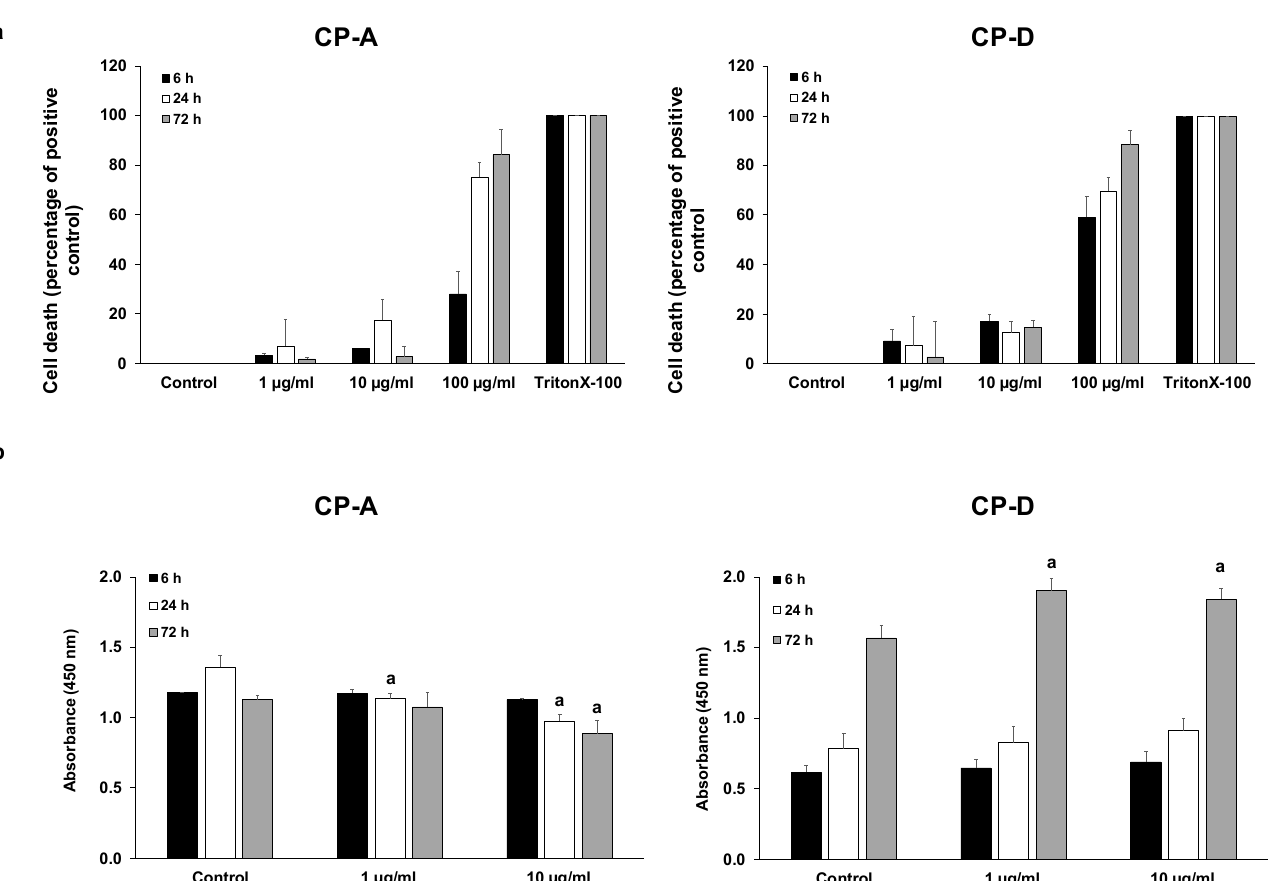
Figure 1. Effects of cigarette smoke extract (CSE) treatment on cell viability and proliferation. Metaplastic (CP-A) and dysplastic (CP-D) esophageal cell lines were exposed to different concentrations of CSE for 6, 24 and 72 h and the effects on cellular viability ( a ) and proliferation ( b ) were studied, using LDH and CCK8 assays, respectively. In the case of viability assay, 0.1% Triton X-100 was used as a positive control. Data represent mean ± SEM of three independent experiments; a = p ≤ 0.05 vs. control.